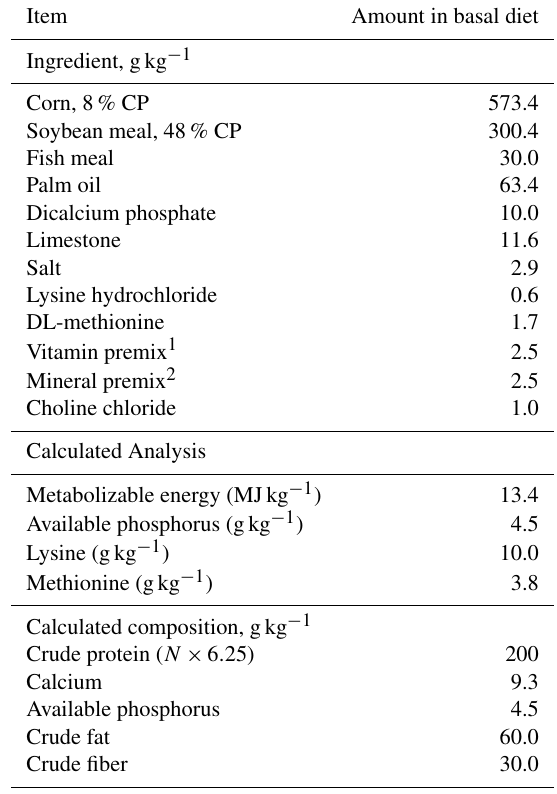
Table 1. Ingredients and calculated composition of the basal diet.